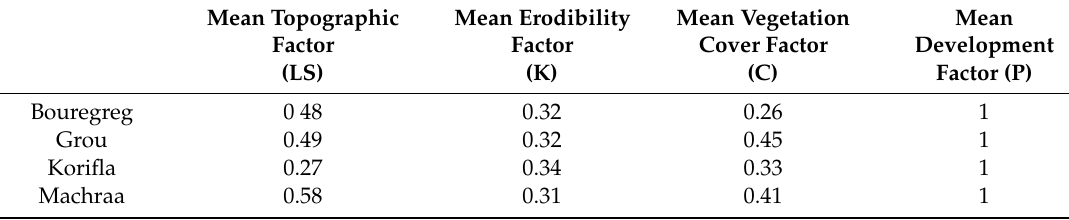
Table 11. Averaging factors for the universal soil loss equation modified per